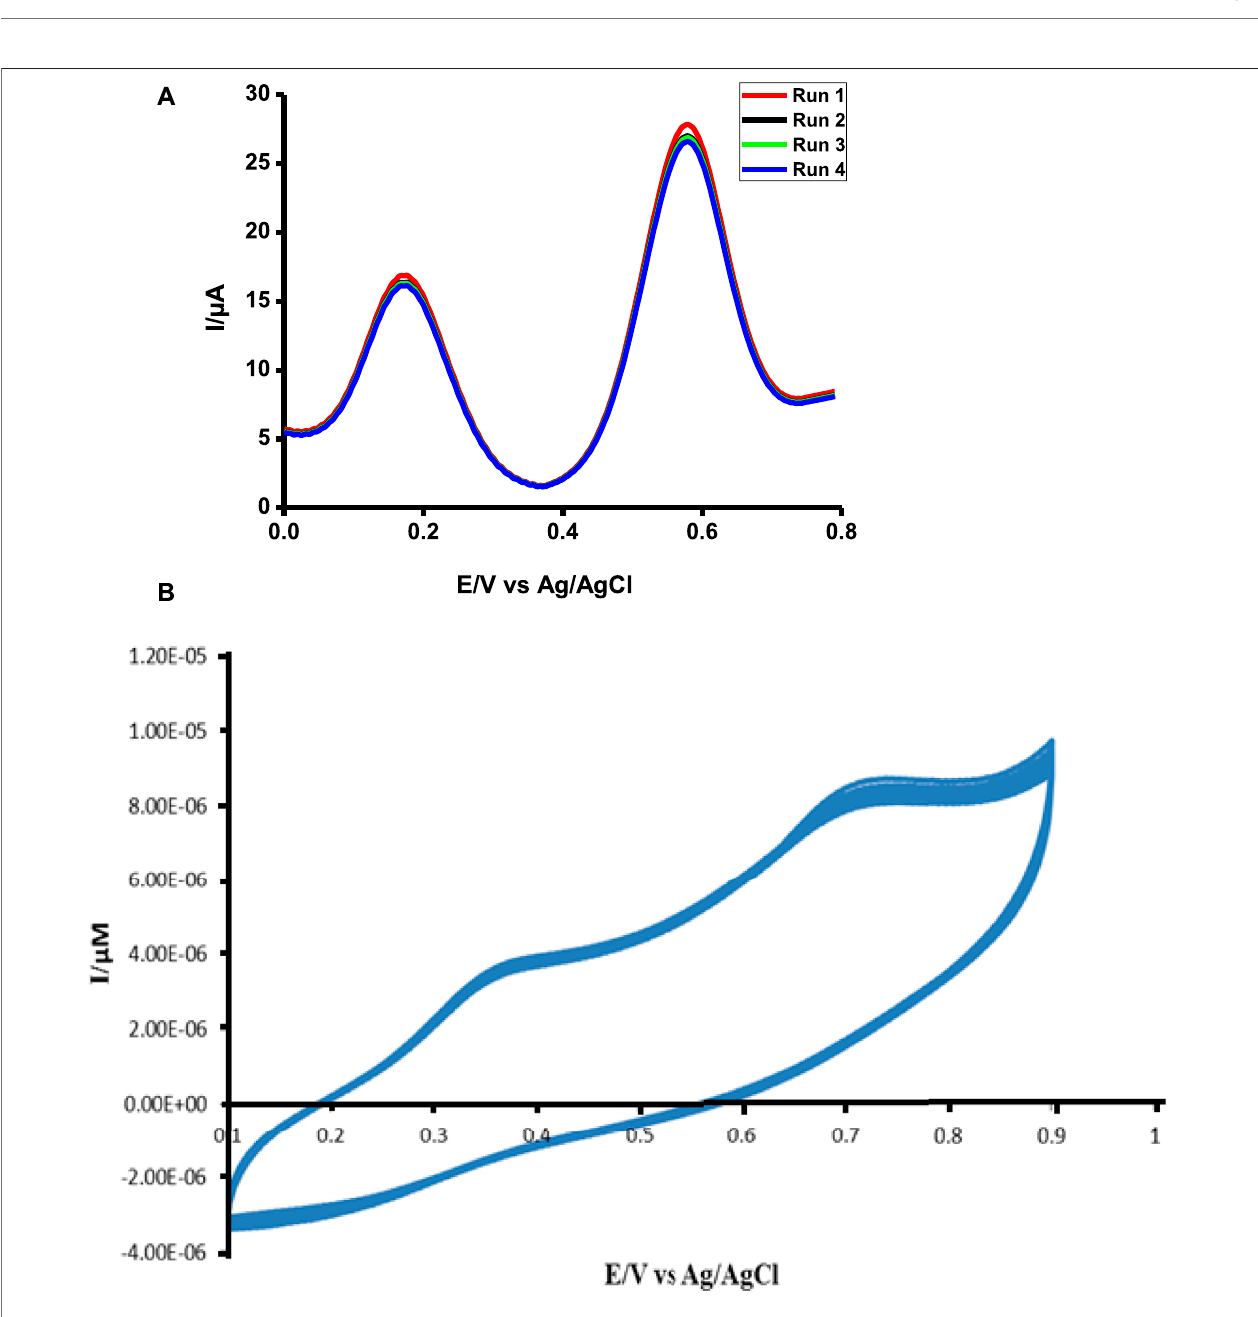
FIGURE 11 | Stability study of poly-CoTCPc-CoTAPc-GONS/GCE in 1 mM ascorbic acid and tryptophan in pH 5 buffer solution using DPV (A) and CV (B) .